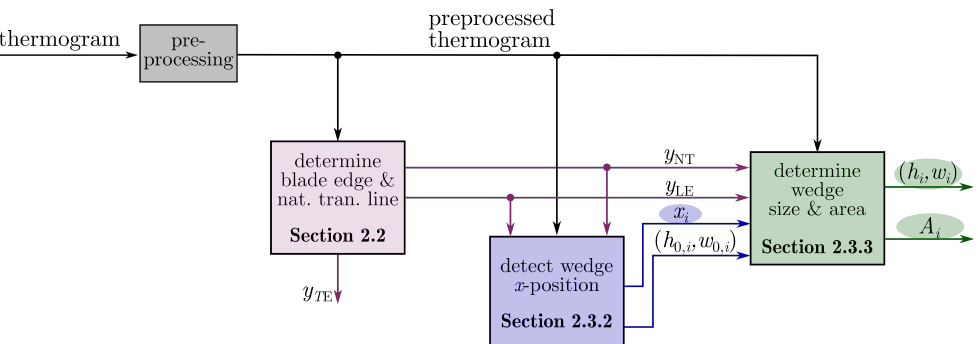
Figure 5. Flowchart of the model-based algorithm. y TE are the y -positions of the trailing edge, y NT the y -positions of the natural transition line and y LE the leading edge’s y -positions. The output quantities, which are highlighted with a colored circular background, are the x -position x i , the height h i , the width w i and the area A i of each turbulence wedge, where i denotes a running wedge